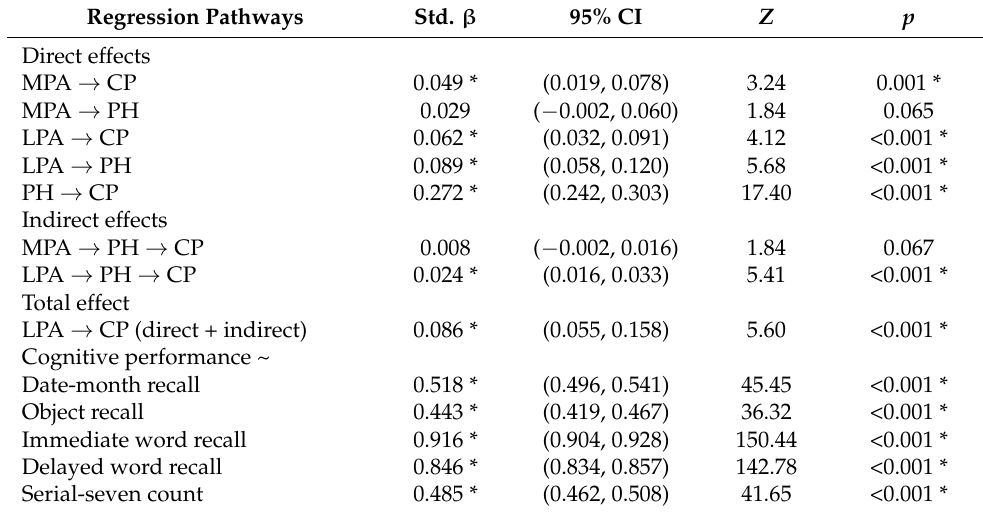
Table 3. Results from the structural mediation model ( n =